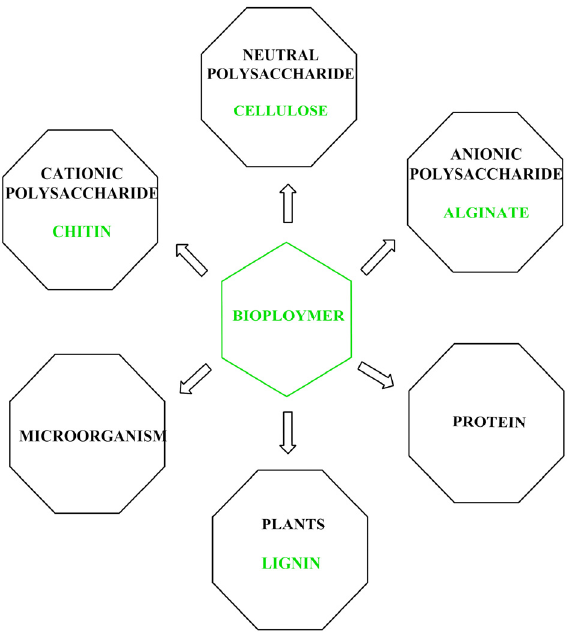
Figure 1. A pictorial depiction of several natural, renewable biopolymers categorized according to their source